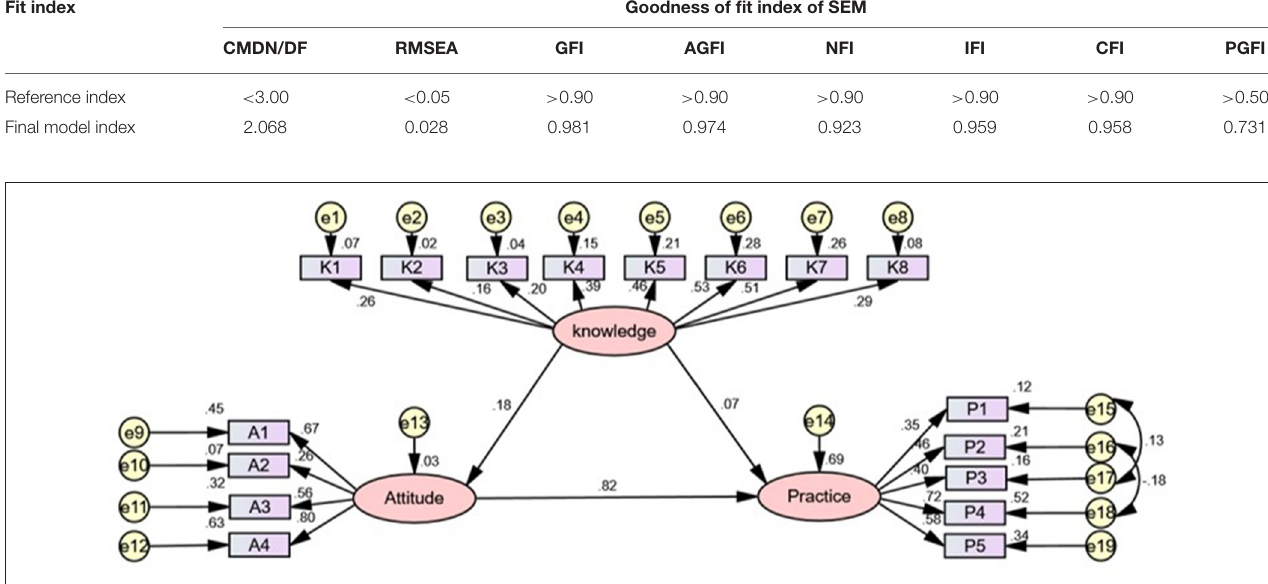
FIGURE 2 | The final SEM. Rectangle shows observed variables, ellipses indicate potential variables, and circles represent residual terms. The values of single-headed arrows represent the standardized coefficients. All paths were significant ( P < 0.05).